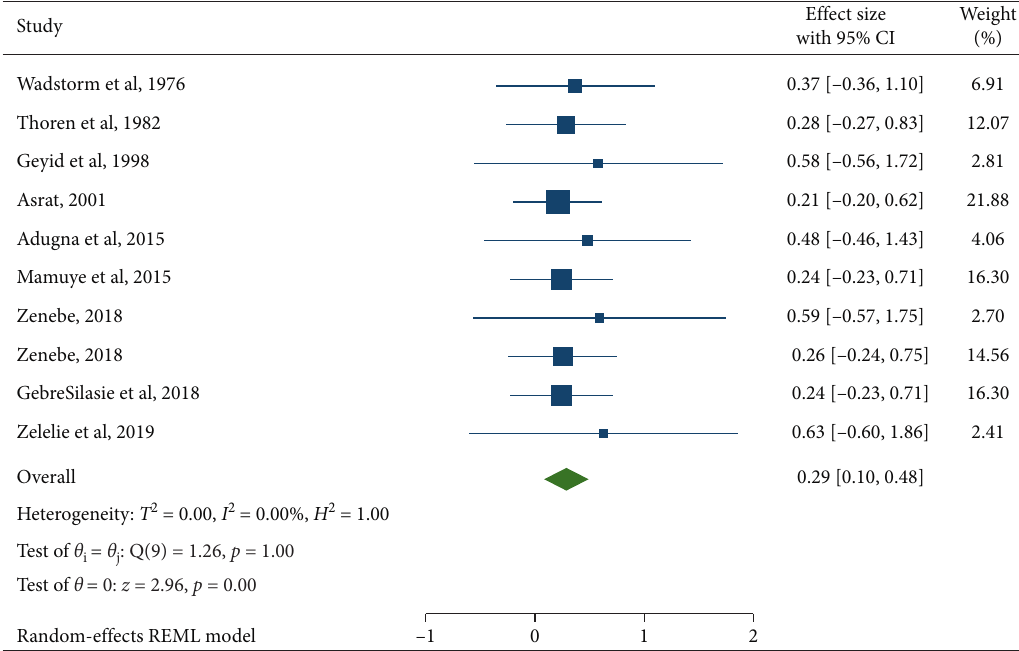
Figure 2: Forest plot of the pooled prevalence of Escherichia coli in under-five children with diarrhea in Ethiopia.